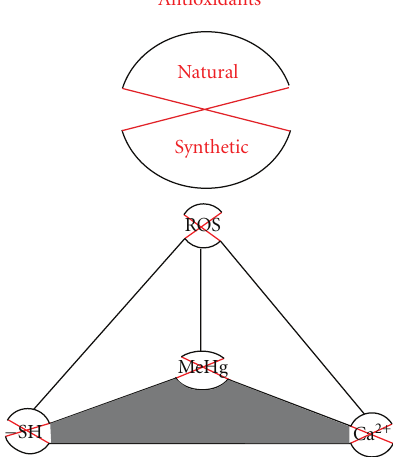
Figure 7: Pyramidal network involved in MeHg neurotoxicity: Arrows denote the interlinked possible pathways by which MeHg may cause cellular damage and the protective e ff ect of natural and synthetic antioxidants against MeHg neurotoxicity by blocking oxidative events triggered via –SH depletion, ROS formation, and Ca 2+ dyshomeostasis. For full details, see the